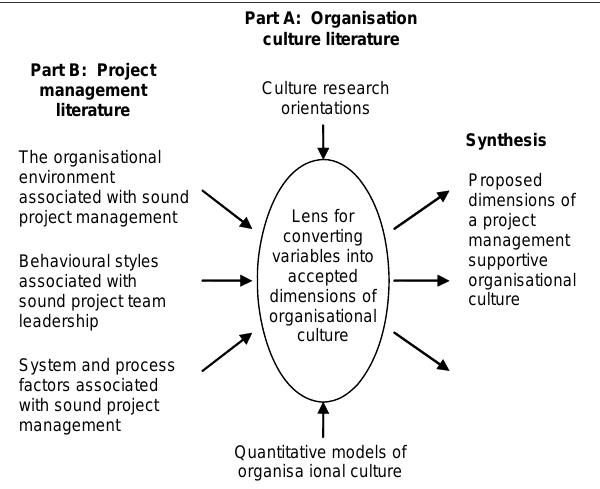
Figure 1: Literature research